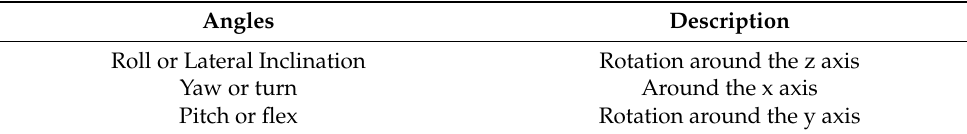
Figure 2. Local reference frame for each monitored part: boot cuff, lower trunk and poles. Table 4. Description of the characteristic rotations around the sensor axis.